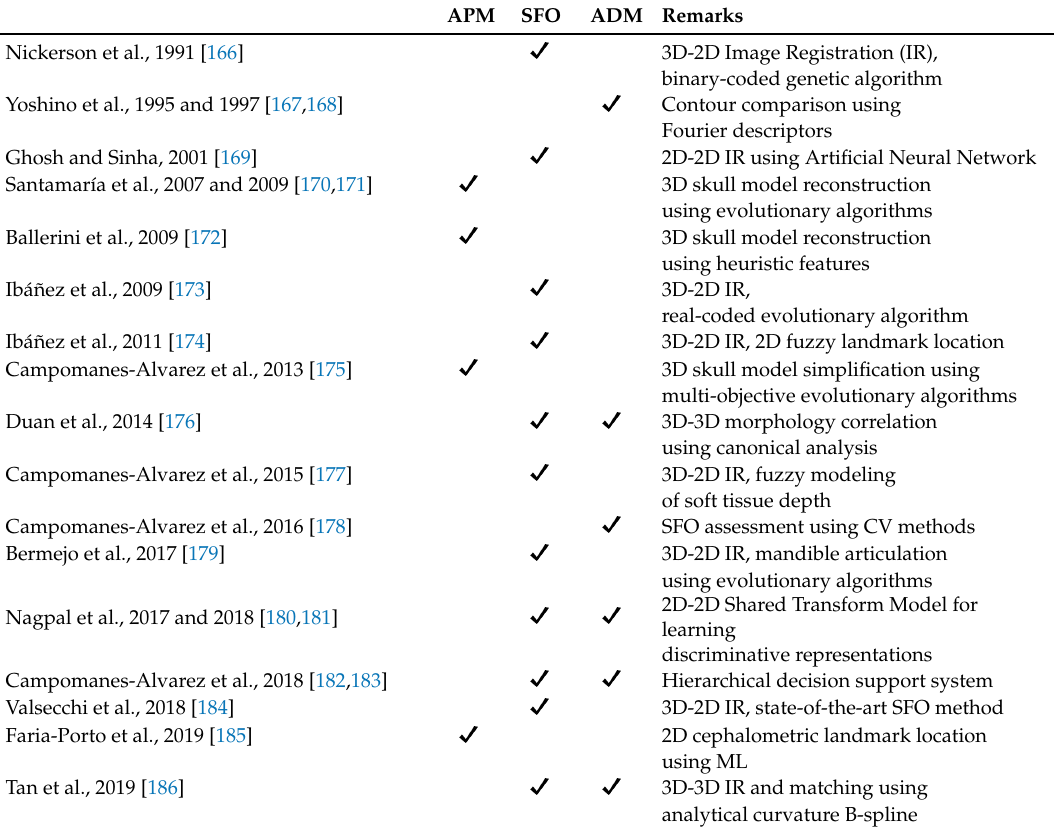
Table 3. An overview of the literature on AI-based approaches to the CFS problem. The stage of the process, i.e., Acquisition and Processing of the Materials (APM), skull-face overlay (SFO) and SFO assessment and decision making (ADM), that is addressed using an AI method is indicated with a D . APM